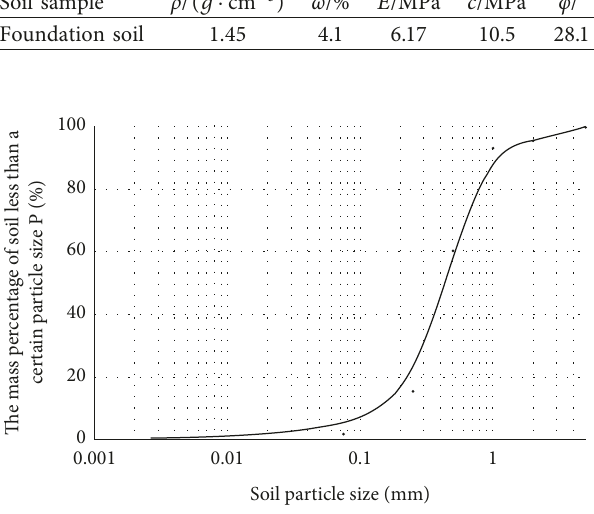
Figure 6: Grain distribution curve of test sand.